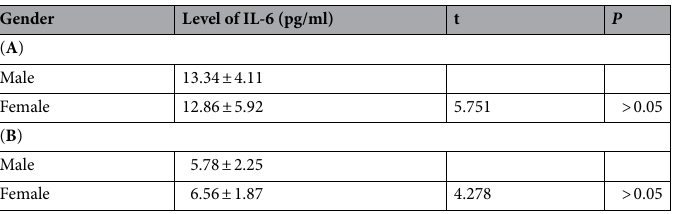
FER1L4 suppressed IL ‐ 6 expression in human chondrocytes. To analyze the effect of FER1L4 expression on IL-6 in chondrocytes, the FER1L4 over-expression plasmid (FER1L4) or the negative control plasmid (NC) was transfected into human chondrocytes (Fig. 4A). Compared to the NC group, FER1L4 over- expression decreased the expression of IL-6 protein within human chondrocytes (Fig. 4B-C). Besides, human chondrocytes were exposed to exogenous IL-6 treatments at 5, 10 and 20 ng, and then FER1L4 levels were detected by qRT-PCR. The data showed that exogenous treatment with IL-6 protein did not affect the expression of the FER1L4 in these cells (Fig. 4D). Thus, FER1L4 regulates IL-6 expression in human chondrocytes.